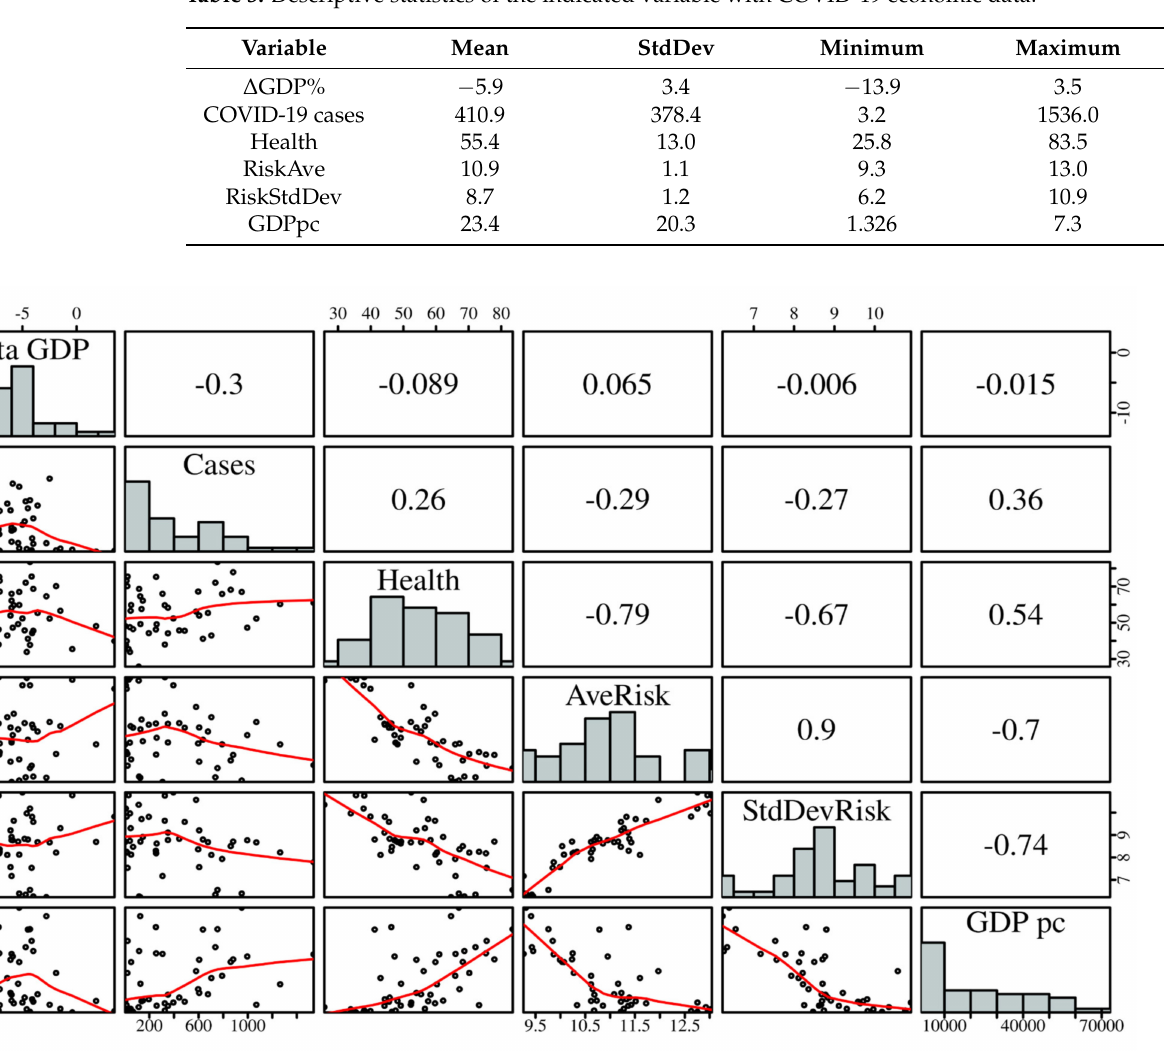
Figure 1. Scatterplots, histograms, and Pearson correlations of the indicated variables with COVID-19 economic